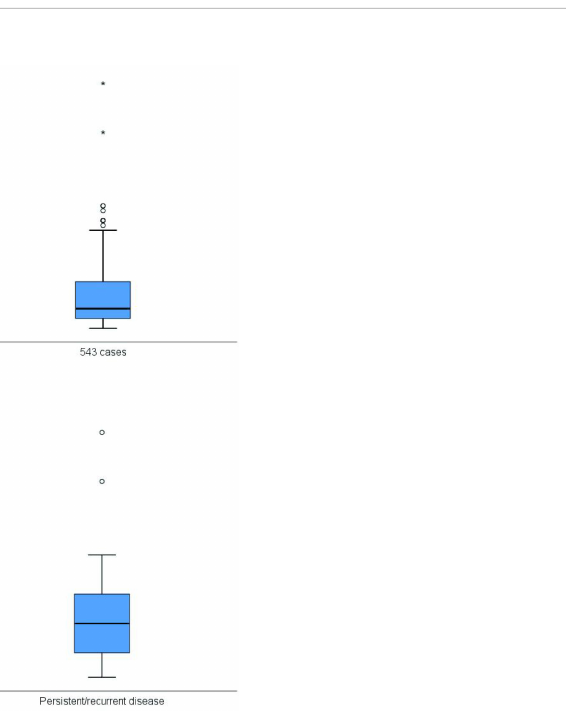
FIGURE 2 (A) Box plot of the distribution of size of the largest metastatic LN in 1310 cases (all patients with size of the largest metastatic LN) and 543 cases (the fi nal cohort consisted of 543 patients). In 1310 cases, the mean value of size of the largest metastatic LN was 0.66cm (range,0-5cm).In 543 cases, the mean value of size of the largest metastatic LN was 0.62cm (range,0-5cm) (p=0.189). (B) Box plot of the distribution of size of the largest metastatic LN based on response to the therapy at the end of follow-up. The corresponding median size of the largest metastatic LN was 0.3cm and 1.1cm, respectively, for patients classi fi ed as disease free and these with persistent/recurrent disease. The size of the largest metastatic LN results are plotted on a logarithmic scale. LN, lymph